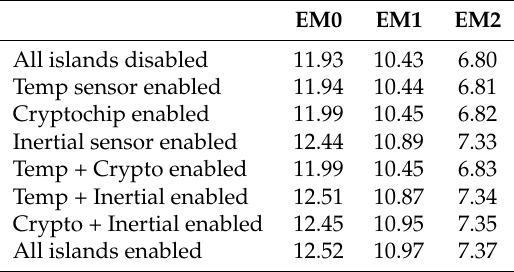
Table 2. Current consumption of the combined low-power modes for the upper active consumption states